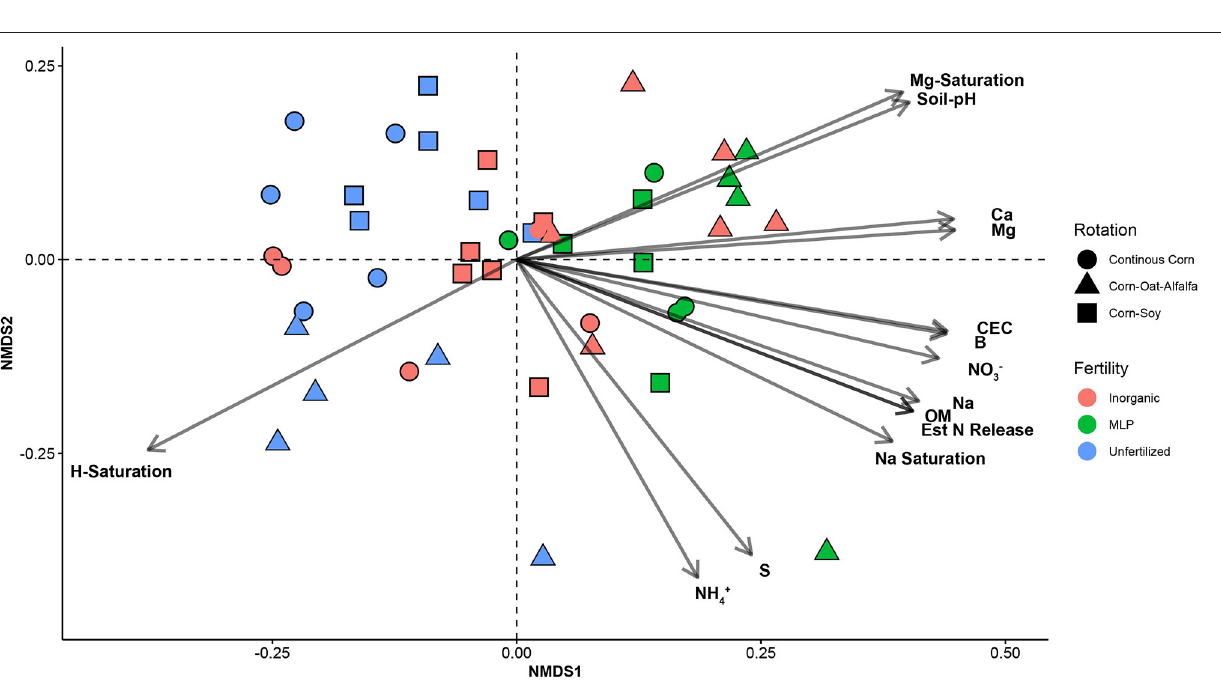
FIGURE 4 | Non-metric multidimensional scaling (NMDS) ordination constructed from a Bray-Curtis dissimilarity matrix of the soil nitrifier community, based on 16S rRNA sequence reads assigned to nitrifier taxa. Edaphic factors were correlated to NMDS1 and NMDS2 using the envfit() function of the vegan package in R. Only significant factors are displayed for visual